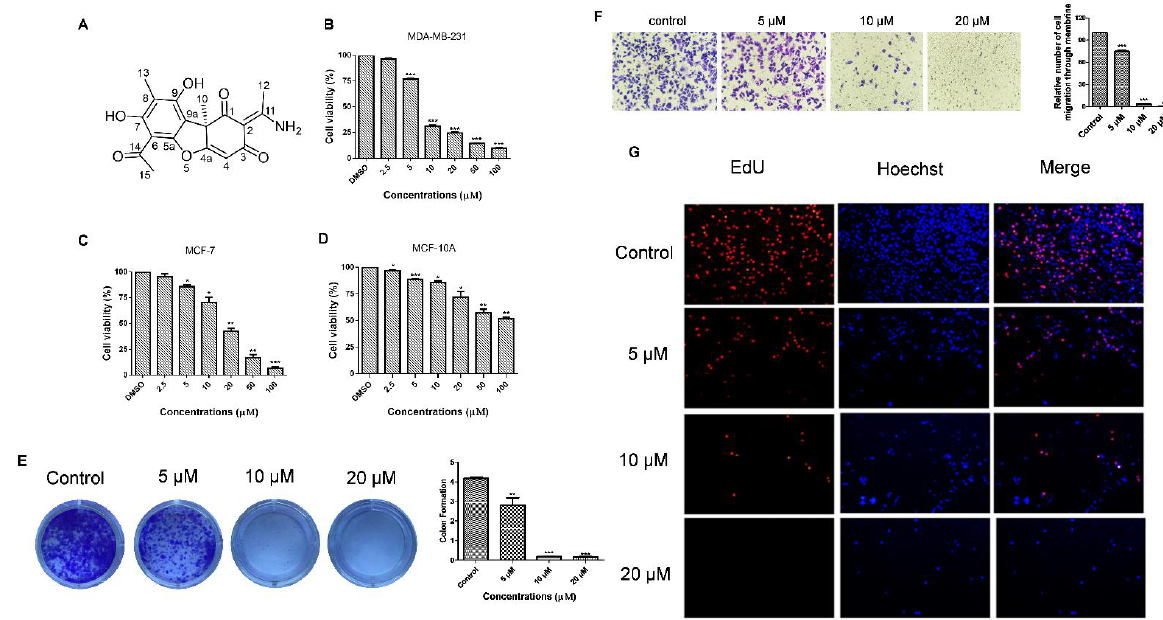
Figure 3. Anti-proliferation and anti-invasion capabilities of usenamine A. ( A ) Chemical structure of usenamine A. ( B ) Cell viability of MDA-MB-231 cells was evaluated through the MTT assay. Cells were treated with different concentrations of usenamine A for 48 h. The results are presented as relative cell viability (%). ( C ) Cell viability of MCF-7 cells was evaluated through the MTT assay. ( D ) Cytotoxicity of usenamine A against normal cells. ( E ) Inhibition of the colony-forming ability of MB-MD-231 cells by usenamine A, as detected by the clonogenic assay. The cells were cultured for 15 days at 37 °C in standard growth media and incubated with different concentrations of usenamine A (5, 10, and 20 μ M) to assess colony growth. ( F ) Inhibition of the invasive capacity of MB-MD-231 cells by usenamine A as detected by the Transwell assay. ( G ) Number of 5-ethynyl-2 ′ -deoxyuridine (EdU)-positive MDA-MB-231 cells after treatment with usenamine A for 48 h. Fetal bovine serum (FBS) was used as a supplement to culture MDA-MB-231 and MCF-7 cells. In the bar chart, the data represent mean ± standard deviation (n = 3). * p < 0.05, ** p < 0.01 and *** p < 0.001 compared to the control group.